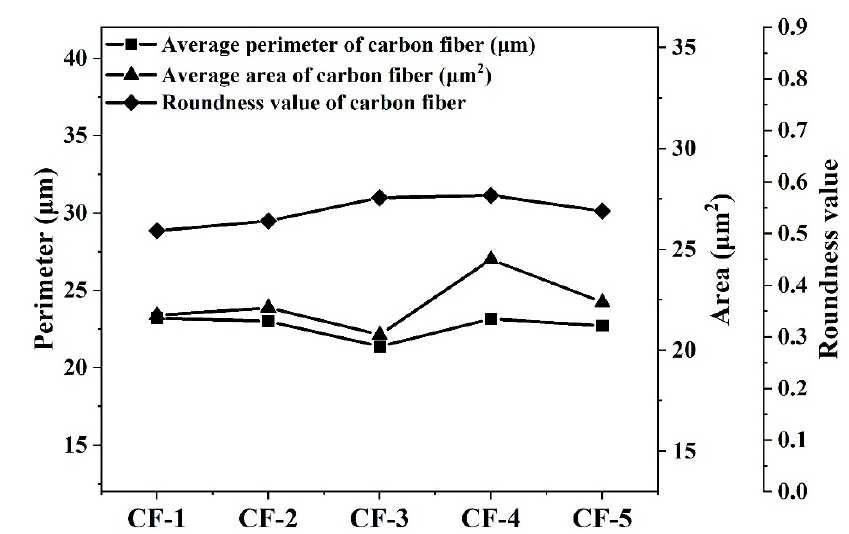
Figure 6. The average perimeter, area and roundness value of CFs.